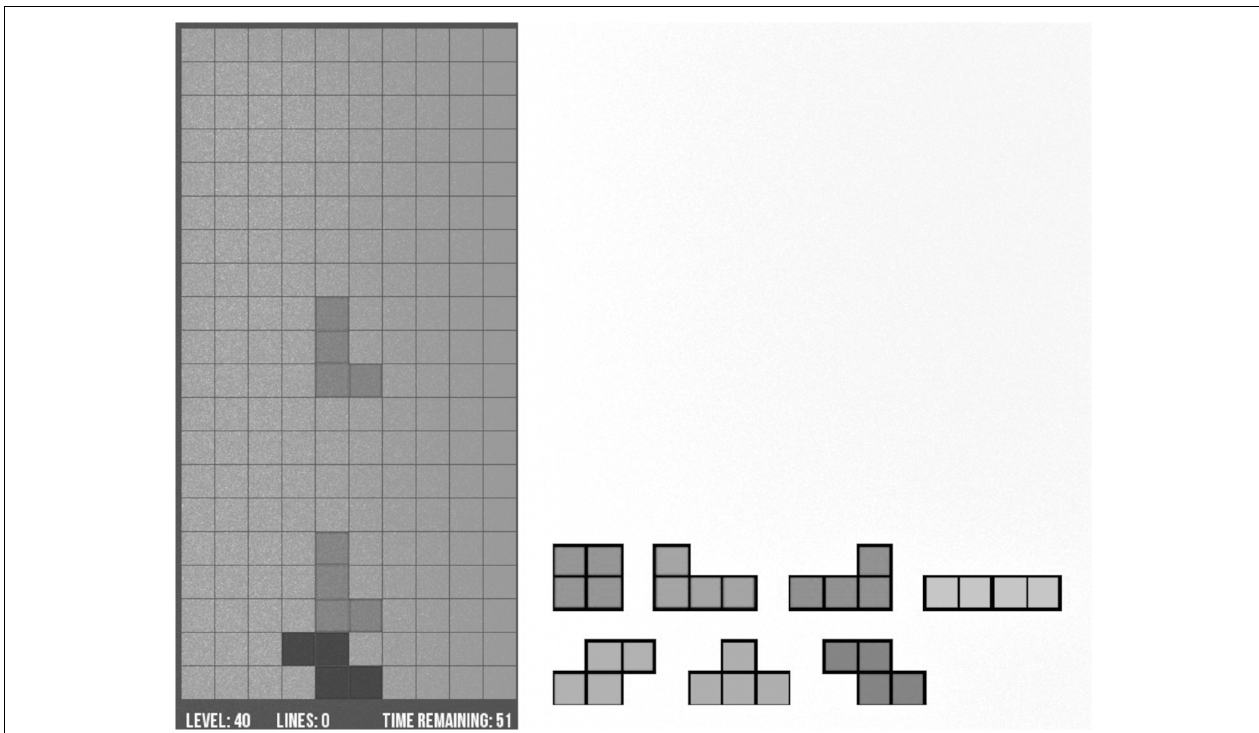
FIGURE 1 | Depiction of the Tetris game and the blocks that were